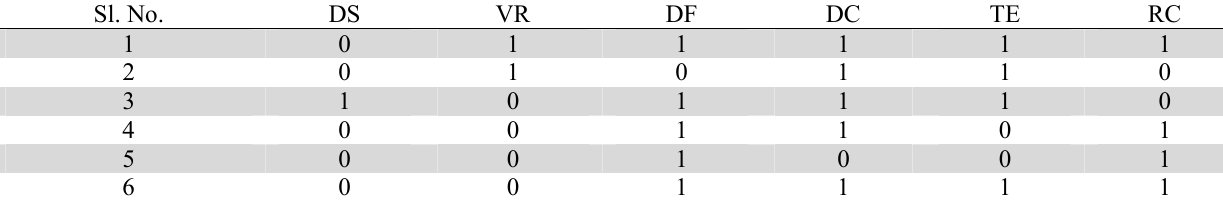
Incidence matrix ( B 2 ) at slicing parameter θ 2 = 0.20 for example 3 Sl. No.